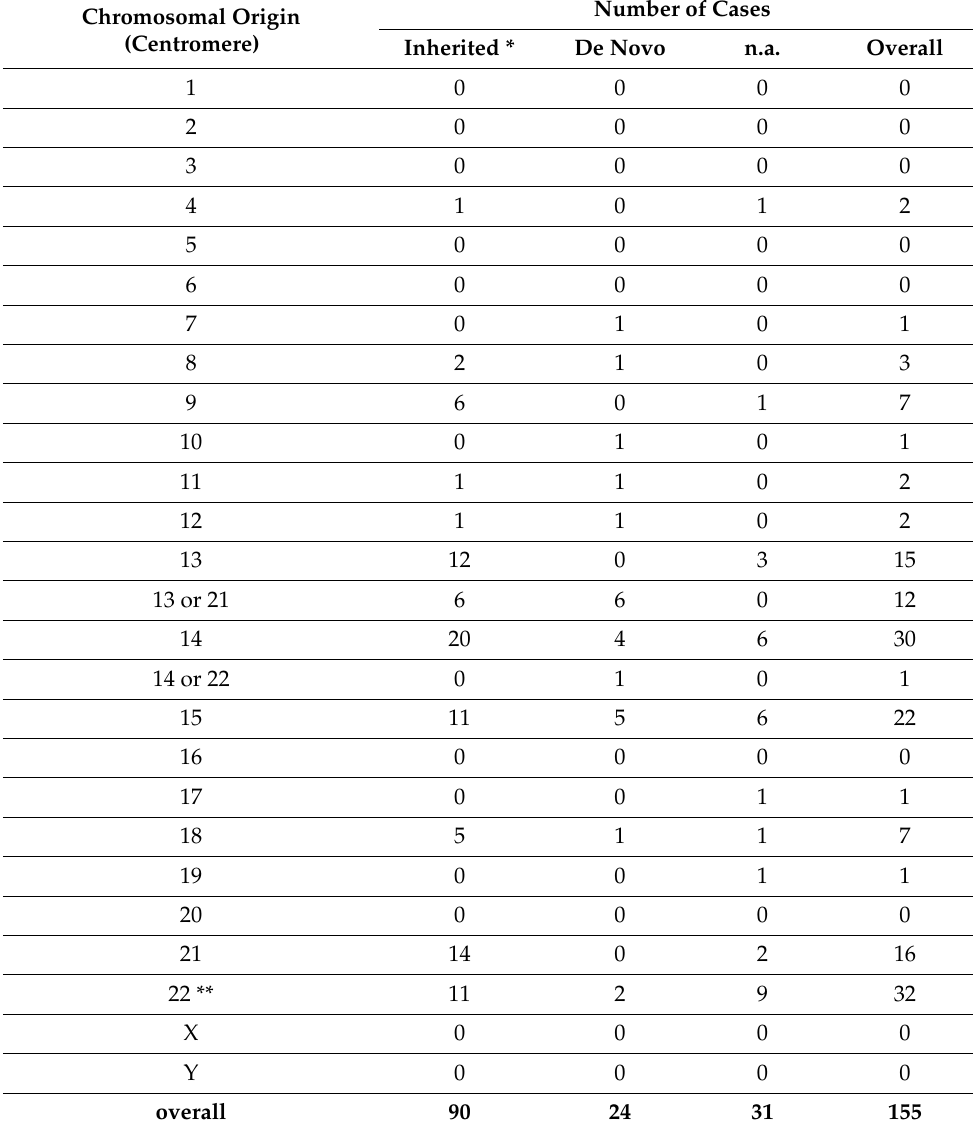
Table 1. Complex sSMCs by chromosomal origin of the centromeric region. Chromosomal Origin